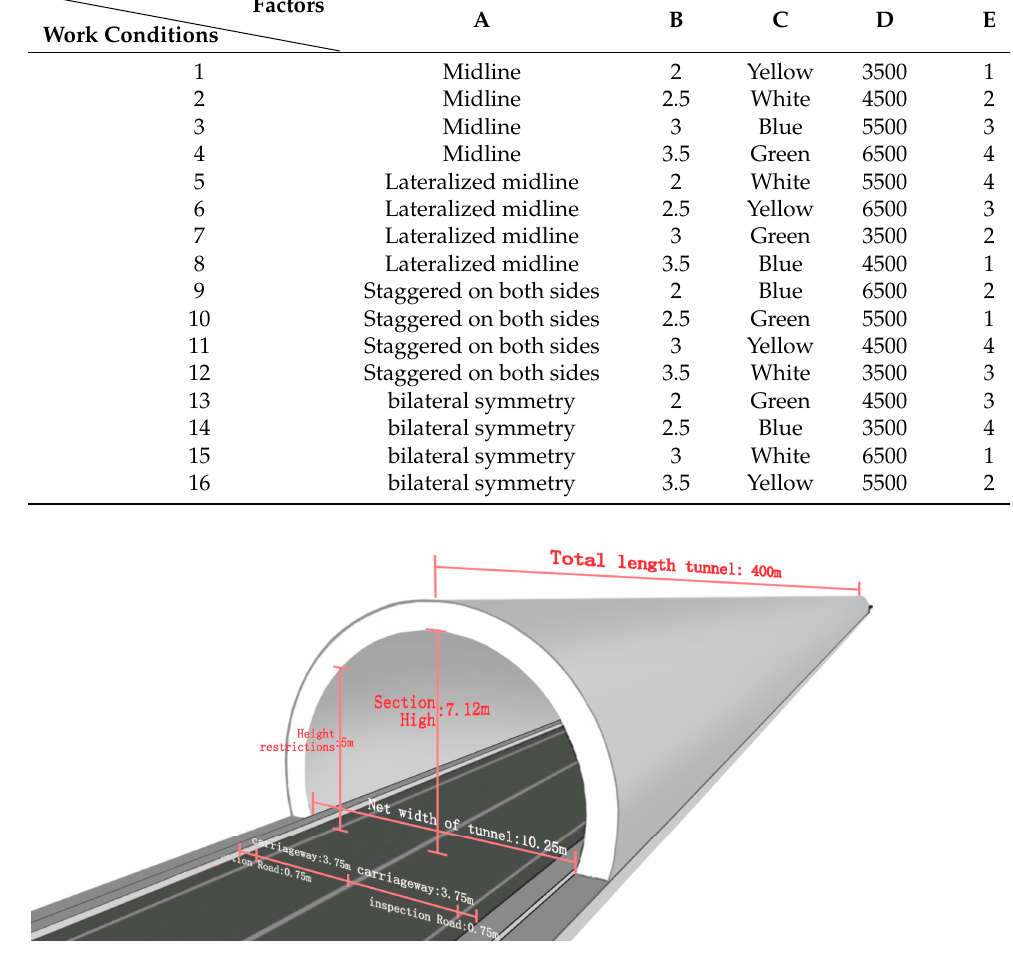
Figure 1. Picture of the experimental model. Table 4. Entrance section and exit section tunnel lighting